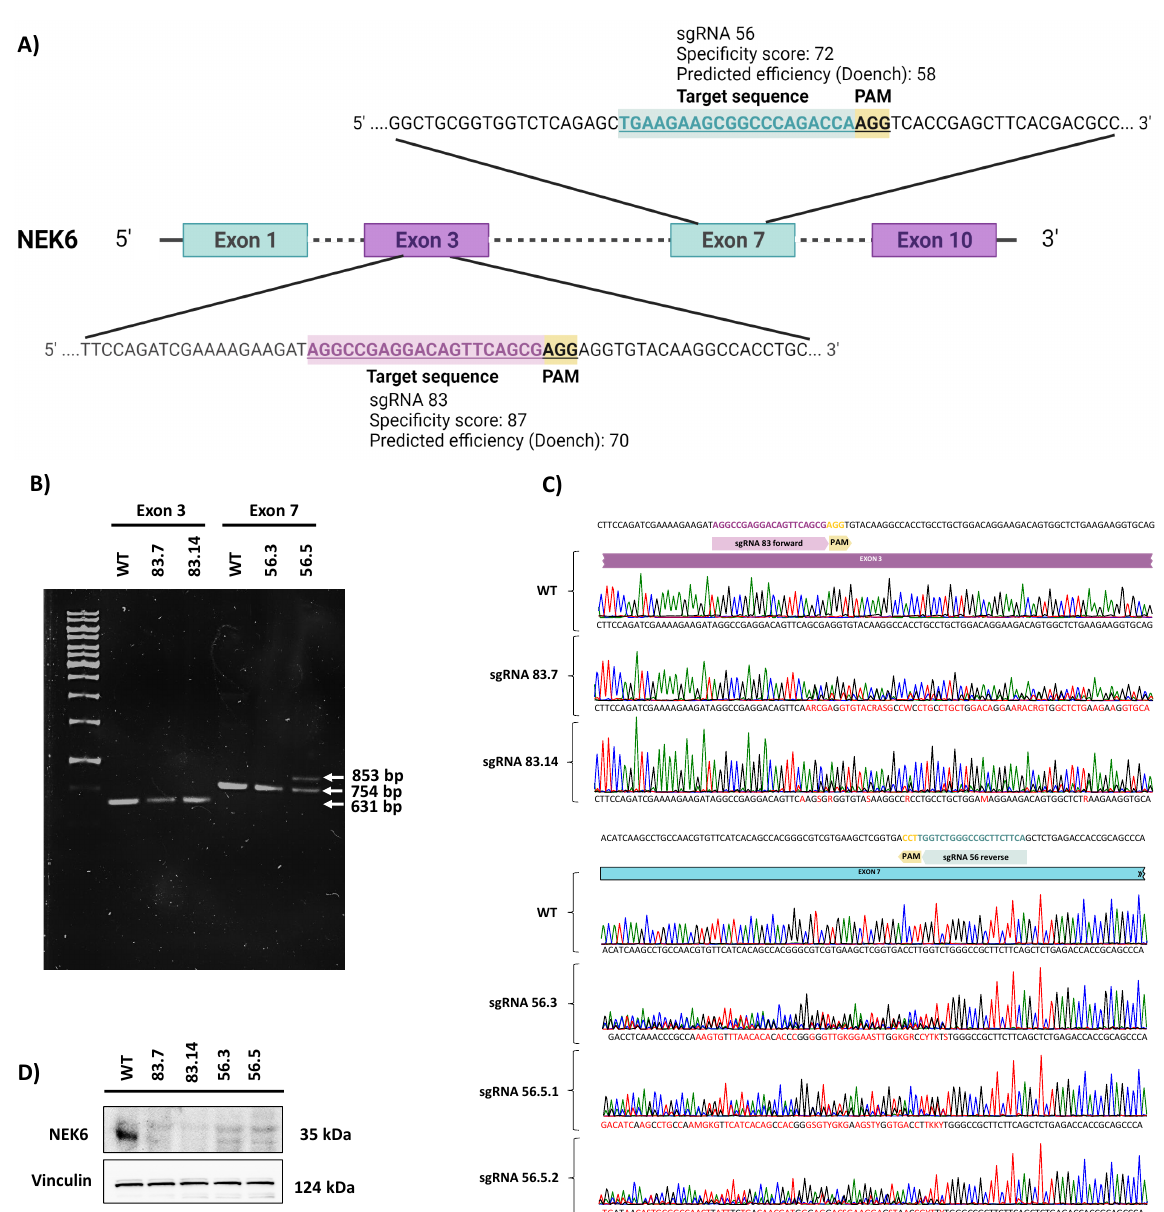
Figure 1. GenerationandvalidationofNEK6-KOinDU-145cells. ( A )Genetargetingstrategyforgenerating NEK6-KO in DU-145 cells. ( B ) PCR amplification of the mutated locus of NEK6-KO cell lines (83.7, 83.14, 56.3, and 56.5). ( C ) DNA sequence analysis showed the presence of indels adjacent to the PAM sequence in NEK6-KO cells. ( D ) Western blot analysis of NEK6 protein expression in WT and NEK6-KO